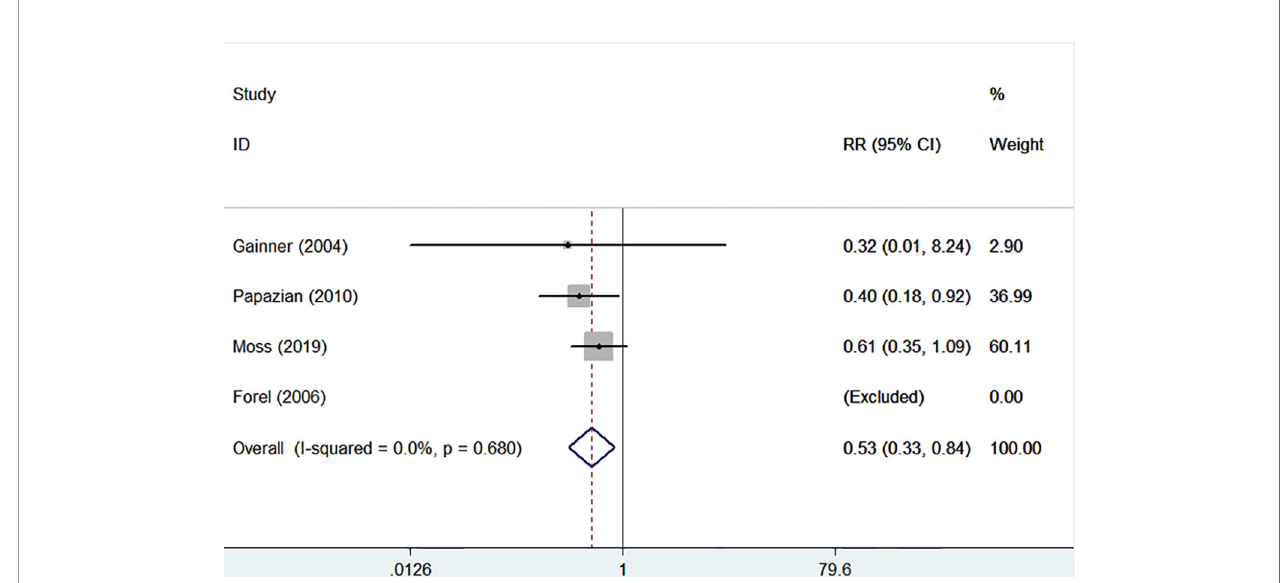
FIGURE 5 | Forest plot of RR and 95% CI for the incidence of barotrauma. The incidence of barotrauma was described in four studies with 1,437 patients (724 in NMBA group vs. 713 in control group). The meta-regression results with fi xed-effects analysis suggested that the incidence of barotrauma was signi fi cantly lower in patients treated with NMBA (RR = 0.53, 95% CI 0.33 to 0.84, P = 0.007, I-squared =